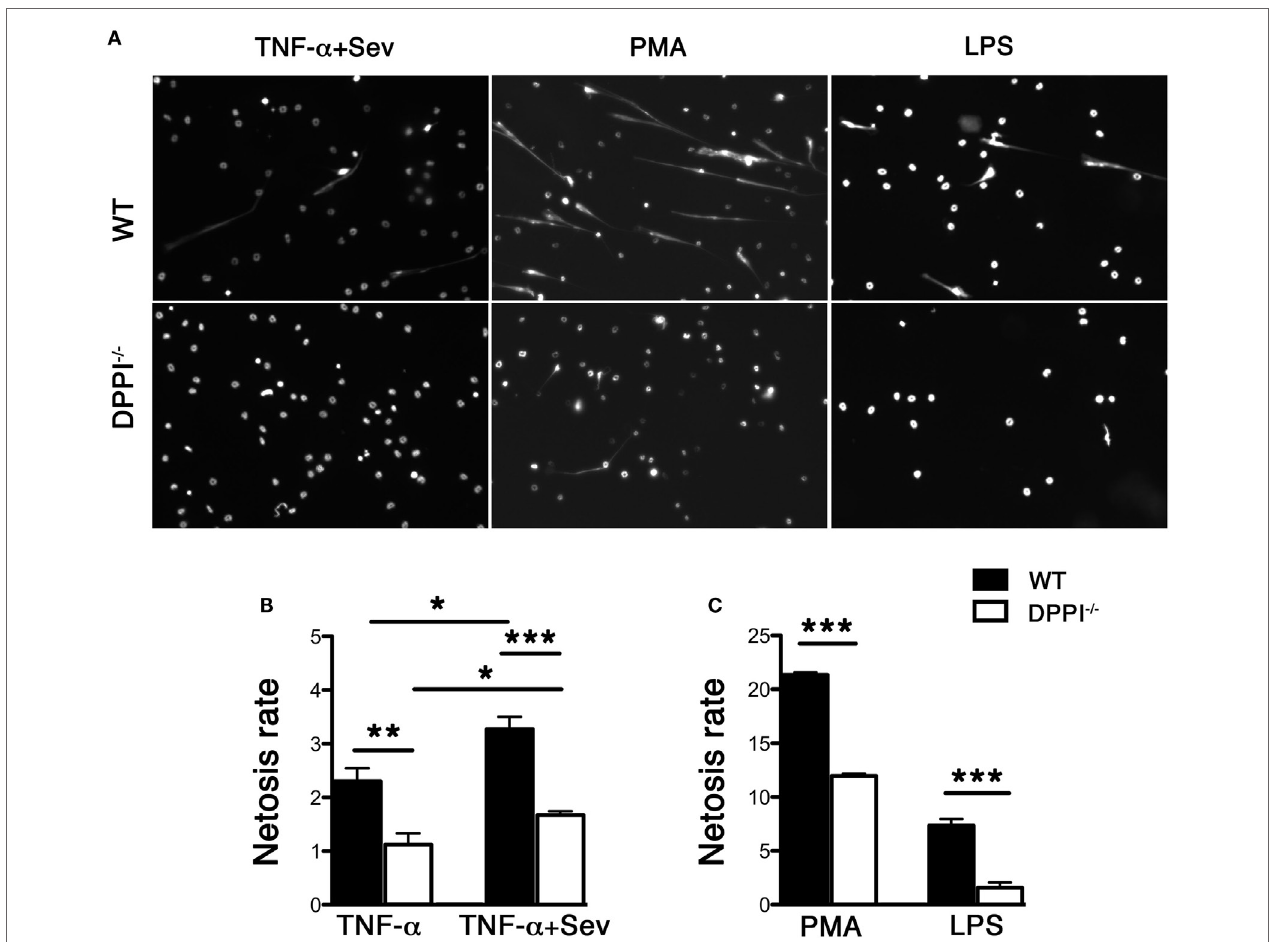
FigUre 2 | absence of DPPi attenuates neT formation in vitro . (a) Bone marrow-derived neutrophils from WT and DPPI − / − mice were stimulated with TNF- α + Sev, PMA, or LPS for 30 min and stained for DNA with Sytox green. (B,c) Quantification of NETs with different stimuli (mean ± SEM derived from three separate experiments). * P < 0.05, ** P < 0.01, *** P < 0.001.